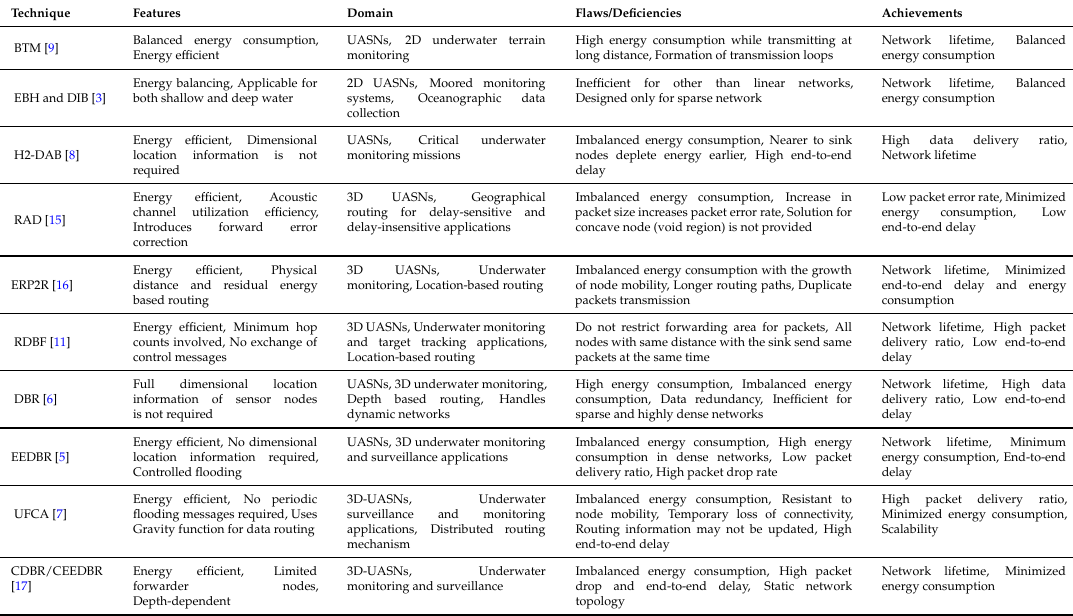
Table 1. Comparison of the state-of-the-art